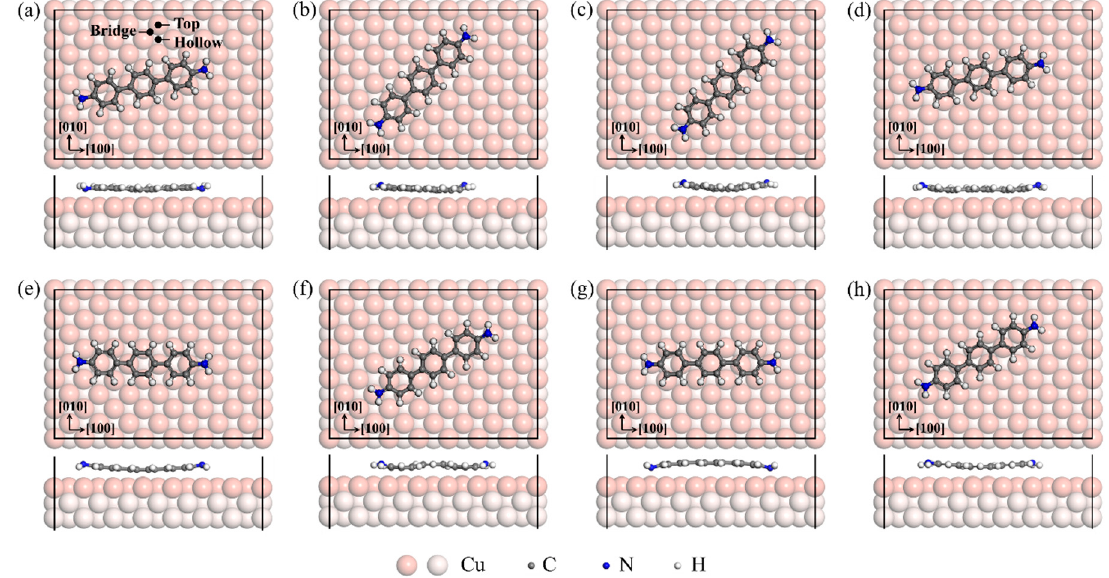
Figure 1. The top and side views of the optimized configurations for DAT/Cu(001) systems from the most stable configuration ( a ) to the least stable one ( h ). The rotation angles are ( a ) 13.2 ◦ , ( b ) 45.5 ◦ , ( c ) 46.0 ◦ , ( d ) 11.9 ◦ , ( e ) 0.9 ◦ , ( f ) 28.5 ◦ , ( g ) 0.9 ◦ , ( h ) 29.0 ◦ , relative to the [100] direction, respectively. The unit cell is marked by black lines. The [100] and [010] directions of the Cu slab are marked as [100] and [010]. The orange and light orange balls represent the top and two bottom layers of Cu atoms, respectively. The gray, blue, and white balls represent the C, N, and H atoms, respectively. The top, hollow, and bridge sites are shown in Figure 1a.